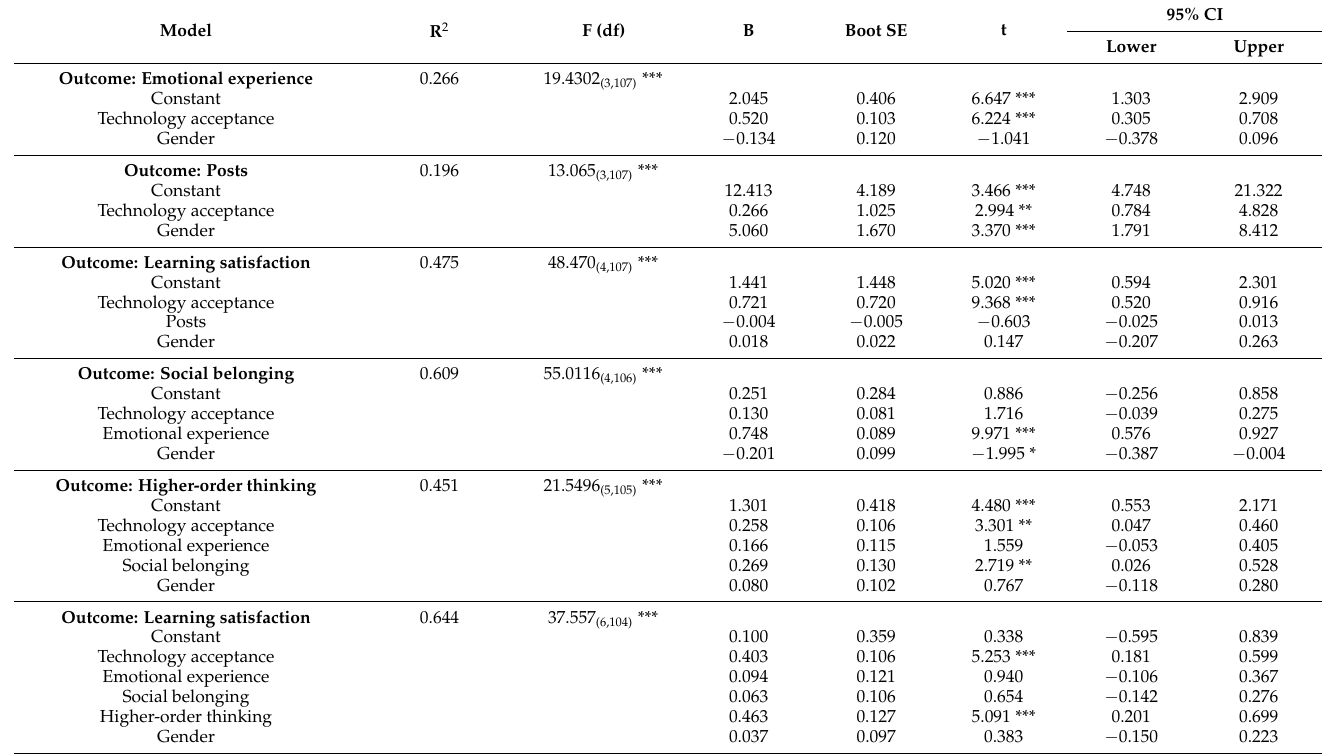
Table 4. Multiple linear regression results among